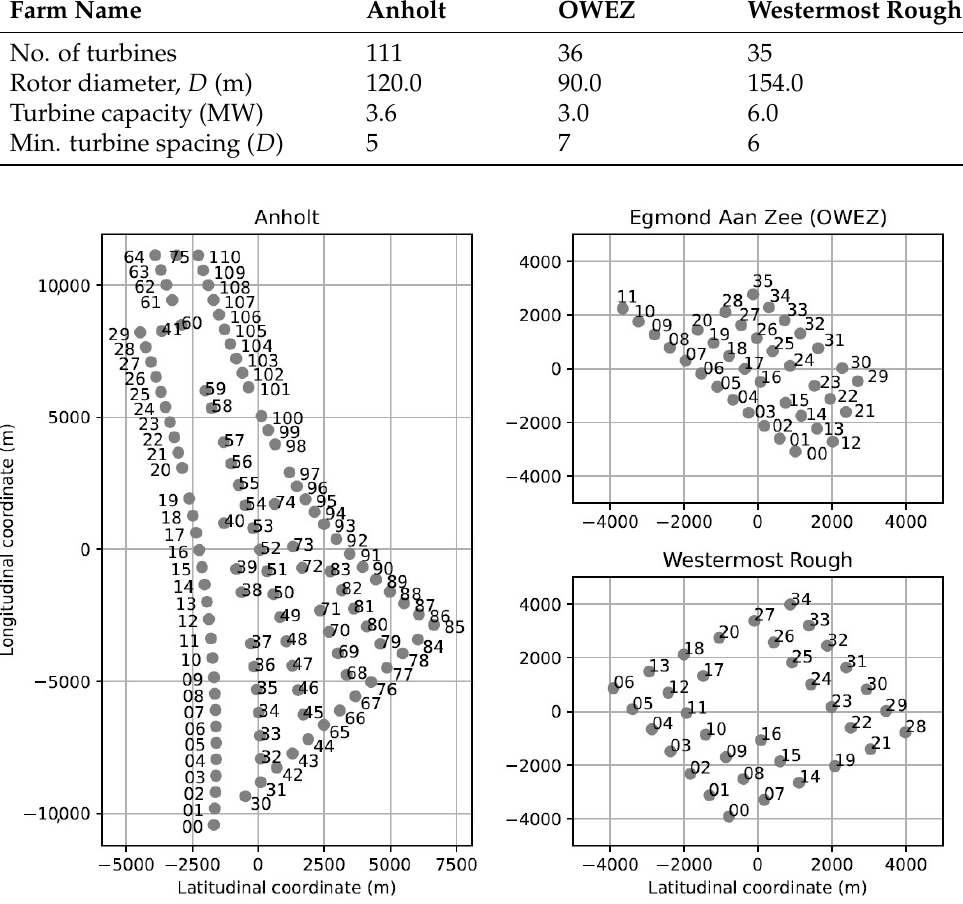
Figure 1. Layouts of the three wind farms: Anholt, Egmond Aan Zee (OWEZ), and Wester- most